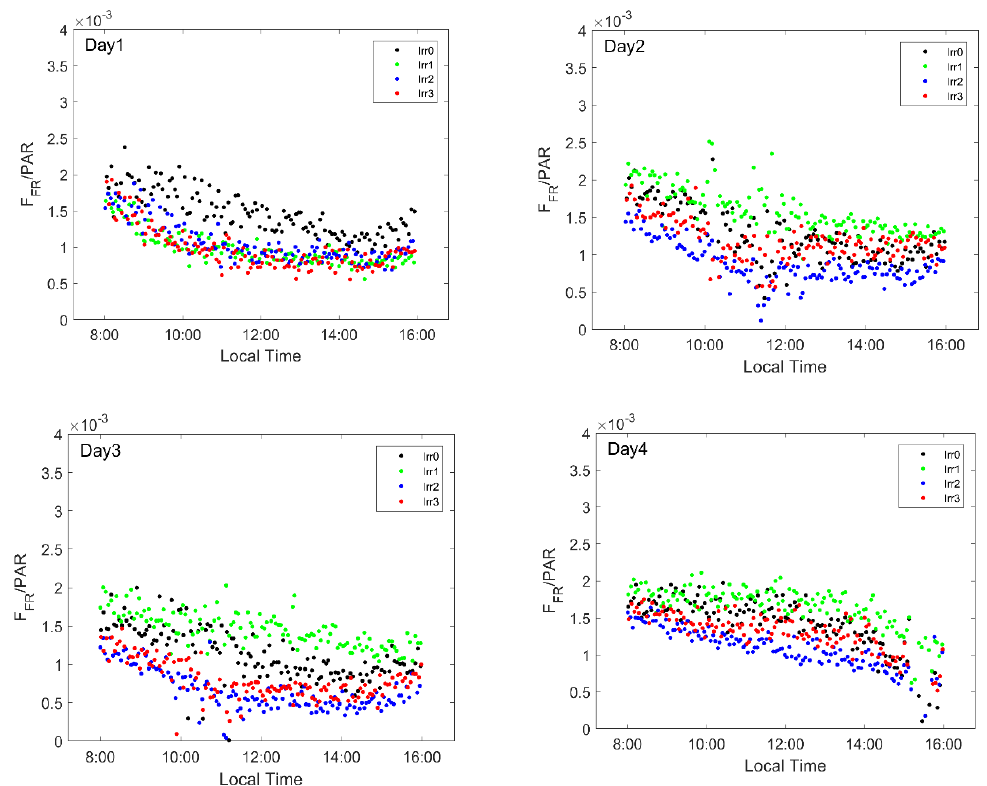
Figure 6. Diurnal variations in far red SIF (F FR ) normalized by photosynthetic active radiation (PAR) during the experiment, with Day1 to Day4 representing the four observation dates (30 July, 31 July, 3 August, 4 August). On the evening of Day1, Irr1 and Irr3 were watered 0.3 m 3 and 0.16 m 3 , respectively. On the evening of Day3, Irr0, Irr1, Irr2, and Irr3 were watered 0.4 m 3 , 0.2 m 3 , 0.3 m 3 , and 0.16 m 3 , respectively.